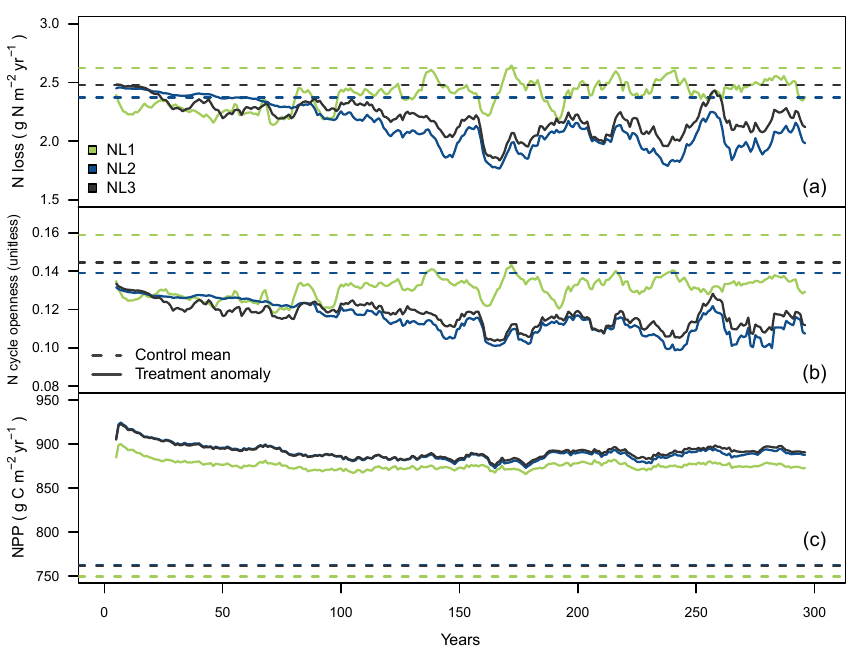
Figure 3. Ten-year moving average responses of total nitrogen (N) loss ( a ; gNm − 2 yr − 1 ), N cycle openness (N loss/net N mineral- ization; b ; unitless) and net primary productivity (NPP; c ; gCm − 2 yr − 1 ) during the local 300-year eCO 2 simulation (380ppm con- trol + 200ppm treatment) at the temperate “ S 0 ” site using the three N loss models; 300-year mean from the control runs and anomaly (treatment − control + control mean) from treatment